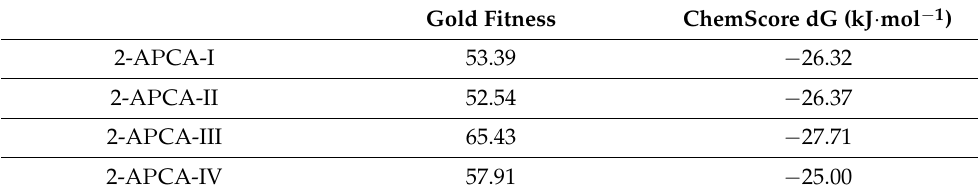
Figure 11. Schematic representation of the interaction of 2-APCA-I ( A ), 2-APCA-II ( B ), 2-APCA-III ( C ), and 2-APCA-IV ( D ) with amino acid residues of binding sites in tubulin. Table 5. Results of the docking studies with GOLD fitness values (gold fitness) and predicted binding free energies